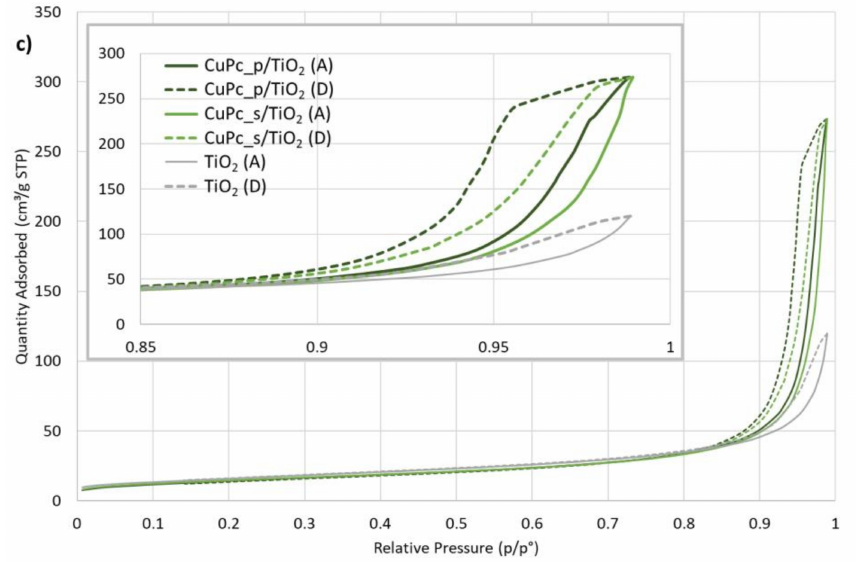
Figure 9. Molecular nitrogen (N 2 ) physisorption isotherms at 77 K for: ( a ) NiPc_s/TiO 2 , ( b ) ZnPc_s/TiO 2 , ZnPc_p/TiO 2 and ZnPc/TiO 2 , ( c ) CuPc_p/TiO 2 and CuPc_s/TiO 2 ;